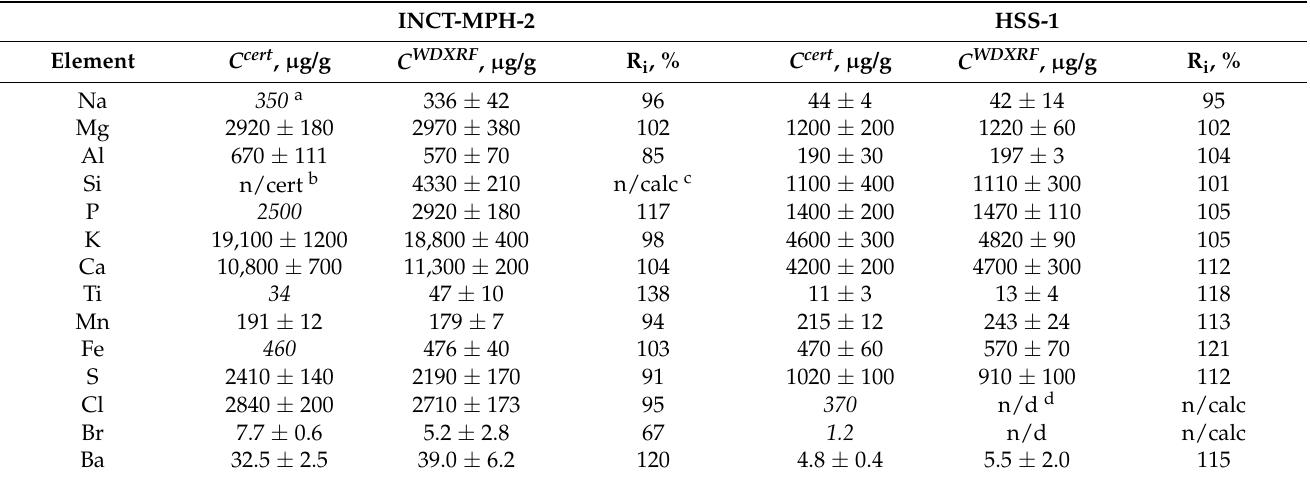
Table 5. The WDXRF results validation with the CRMs of